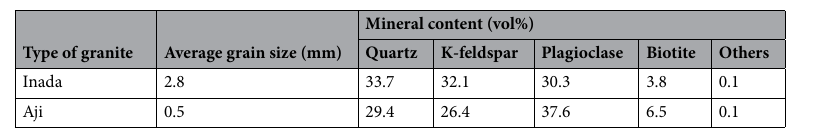
Table 1. Average grain size and mineral composition of the two types of